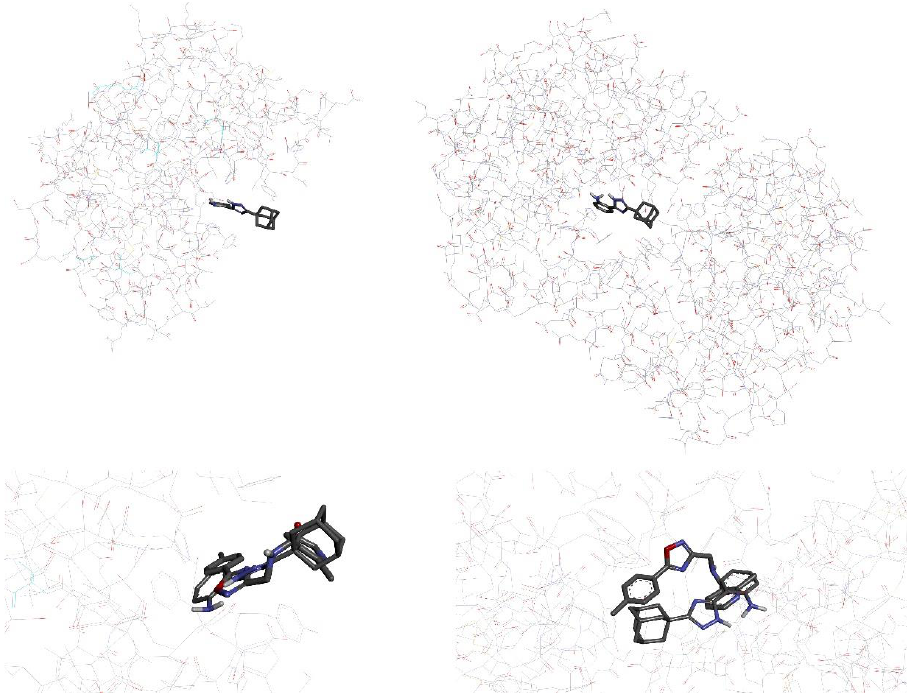
Figure 4. Visual representation (3D) of triazole 5 fit into the active site of A. niger chitin deacetylase ( Ang CDA; left up) and A. nidulans chitin deacetylase ( An CDA; right up); configuration of triazole 5 simultaneously fitting with J0750-4187 into the CDA-binding pocket of A. niger (left down) and A. nidulans (right down).